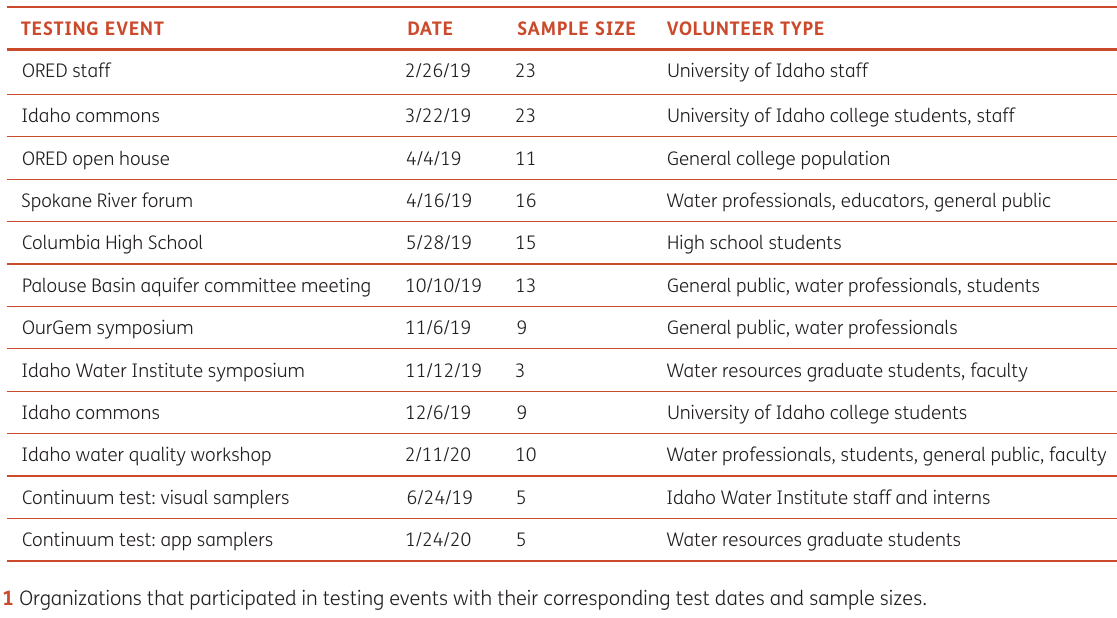
Experiment 1: humans versus smartphone app